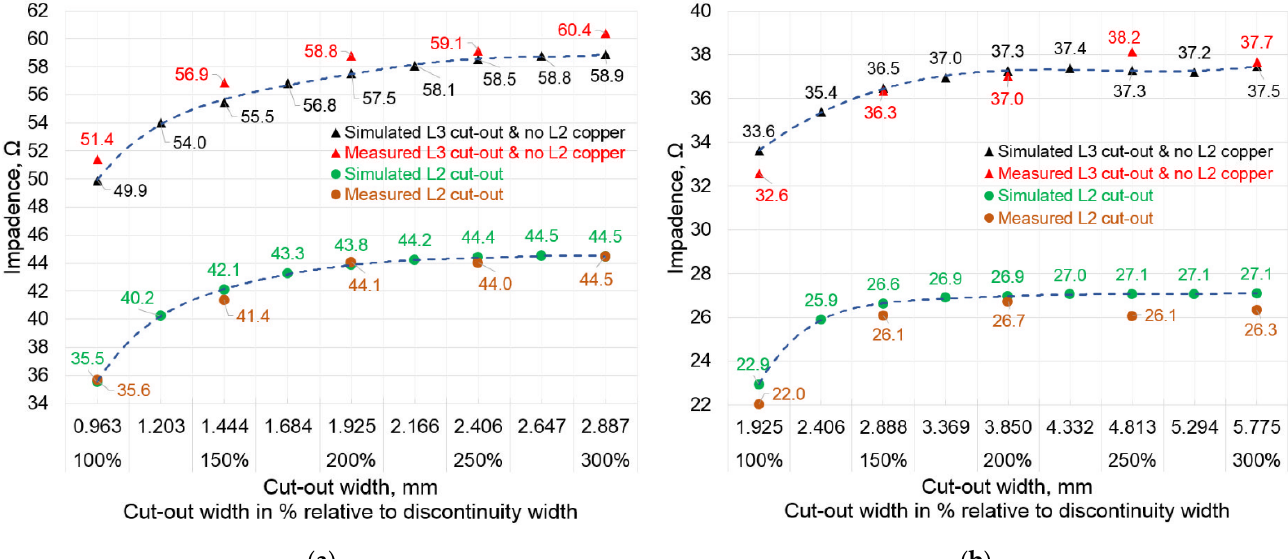
Figure 6. Impedance dependence on different cut-out sizes when cut-outs are made in the second L2 and third L3 inner PCB layers: ( a ) at 1:2.5 track-to-discontinuity; ( b ) at 1:5.0 track-to-discontinuity.